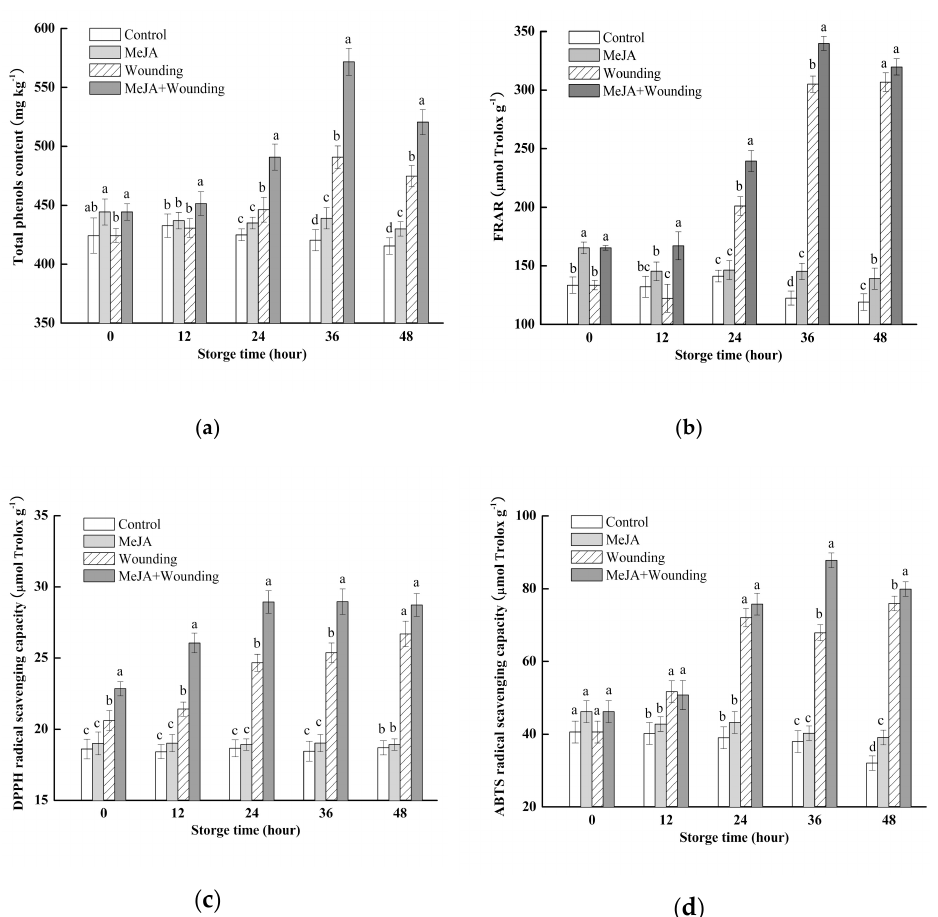
Figure 2. Effect of MeJA treatment and wounding stress on the content of total phenols ( a ), FRAR ( b ), DPPH ( c ), ABTS ( d ) of broccoli during 48 h of storage at 20 °C. Columns with vertical bars represent DPPH ( c ), ABTS ( d ) of broccoli during 48 h of storage at 20 ◦ C. Columns with vertical bars represent the mean ± SD ( n = 3). the mean ± SD ( n =